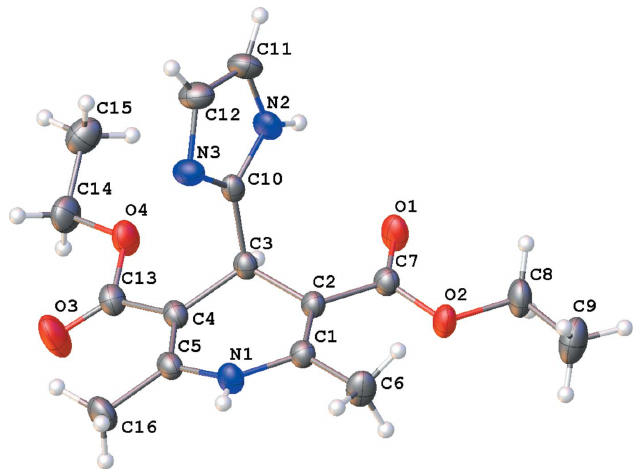
Figure 1 The molecular structure of the title compound, showing the atom- labelling scheme with displacement ellipsoids drawn at the 30% probability